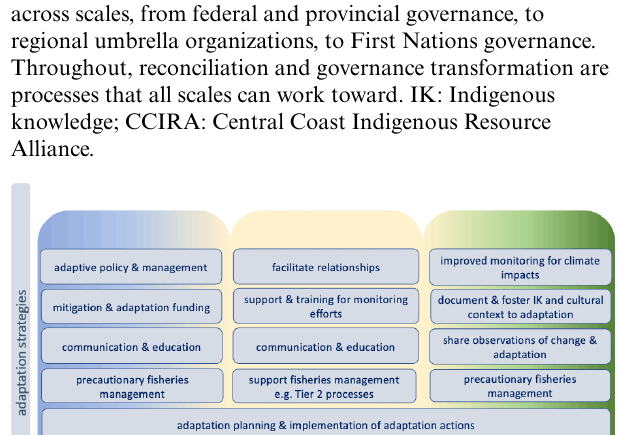
Fig. 4 . Adaptation actions that emerged from these interviews across scales, from federal and provincial governance, to regional umbrella organizations, to First Nations